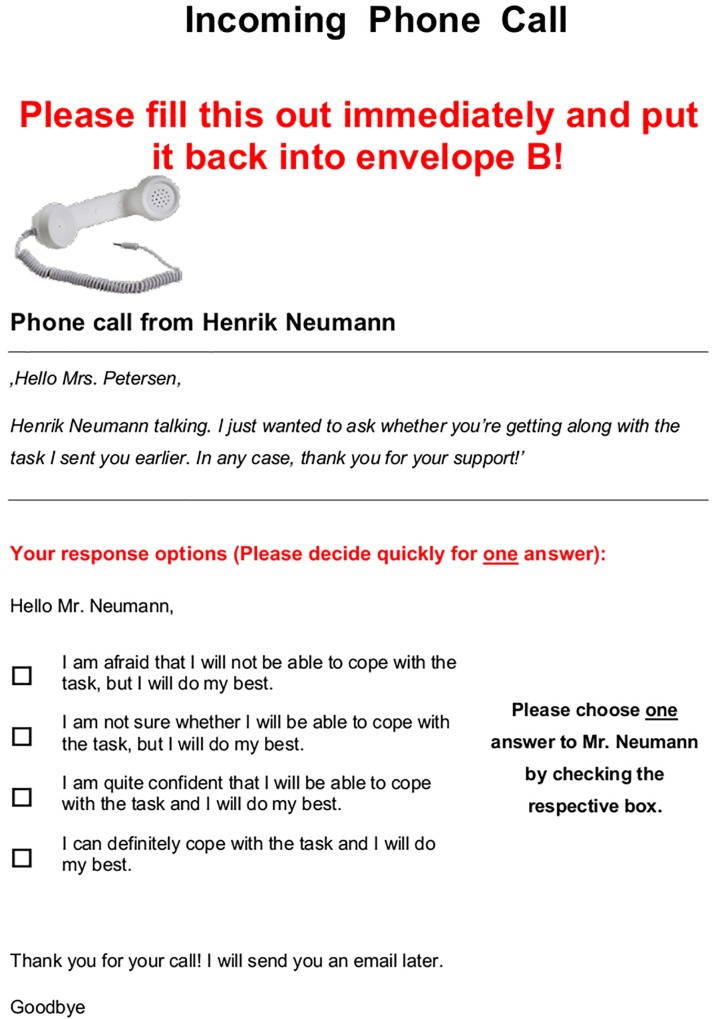
Paper-based EES event “Phone call” with one EES item (translated from German).